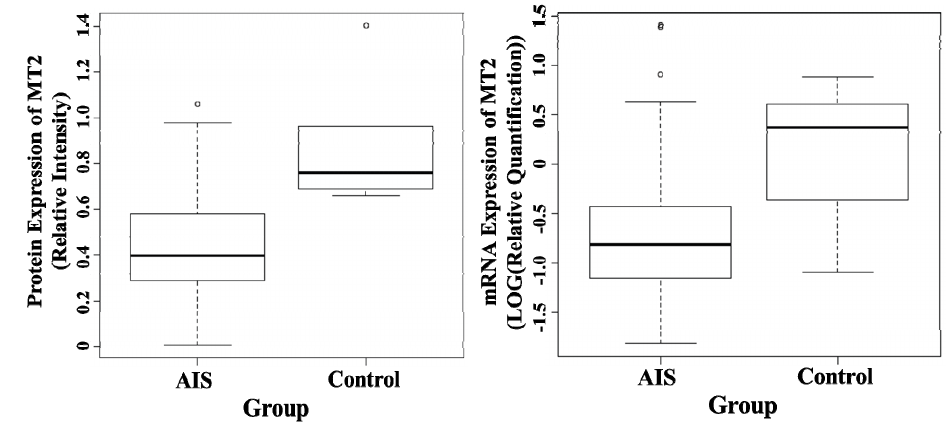
Figure 2. Boxplot of protein expression (left) and mRNA expression of melatonin receptor 2, MT2 (right). The protein level was measured by Western Blot, and beta-actin was used as an internal control. The mRNA level was measured by RT-PCR using TaqMan with a pre-made primer. The results were quantified using a value relative to a control sample. The bottom and top of the box are the twenty fifth and seventy fifth percentile and, the band in the box is the median. The ends of the whiskers represent the lowest datum within 1.5 interquartile range (IQR) of the lower quartile and the highest datum within 1.5 IQR of the upper quartile. Data not included between the whiskers are plotted as